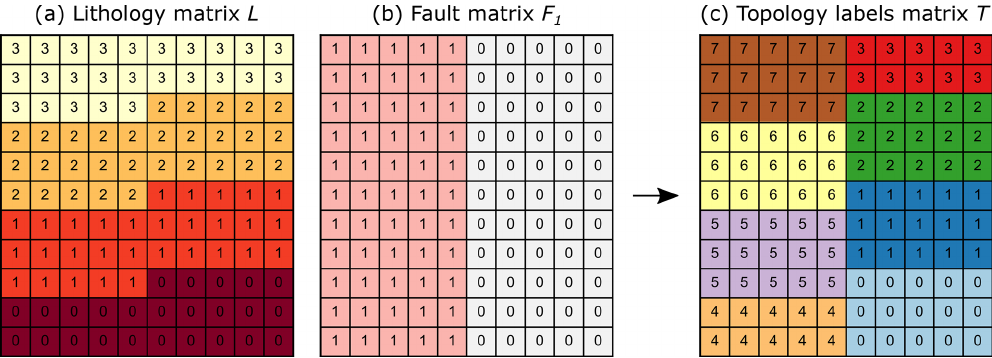
Figure 2. (a) Lithology matrix L of an example 2-D geomodel that consists of four layers and a vertical fault in the center; (b) fault matrix F of the geomodel; (c) topology labels matrix T of the geomodel.